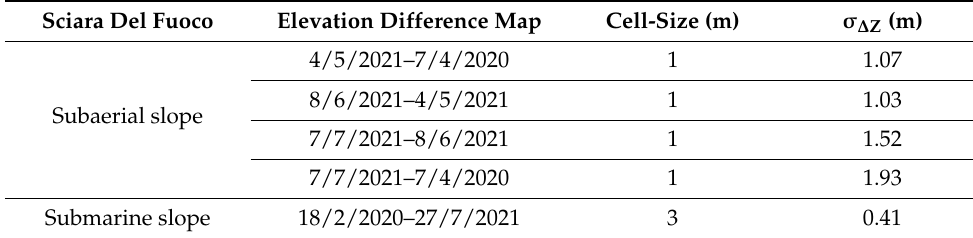
Table 5. Cell-size and σ ∆ Z of the different elevation difference maps used for this study. Sciara Del